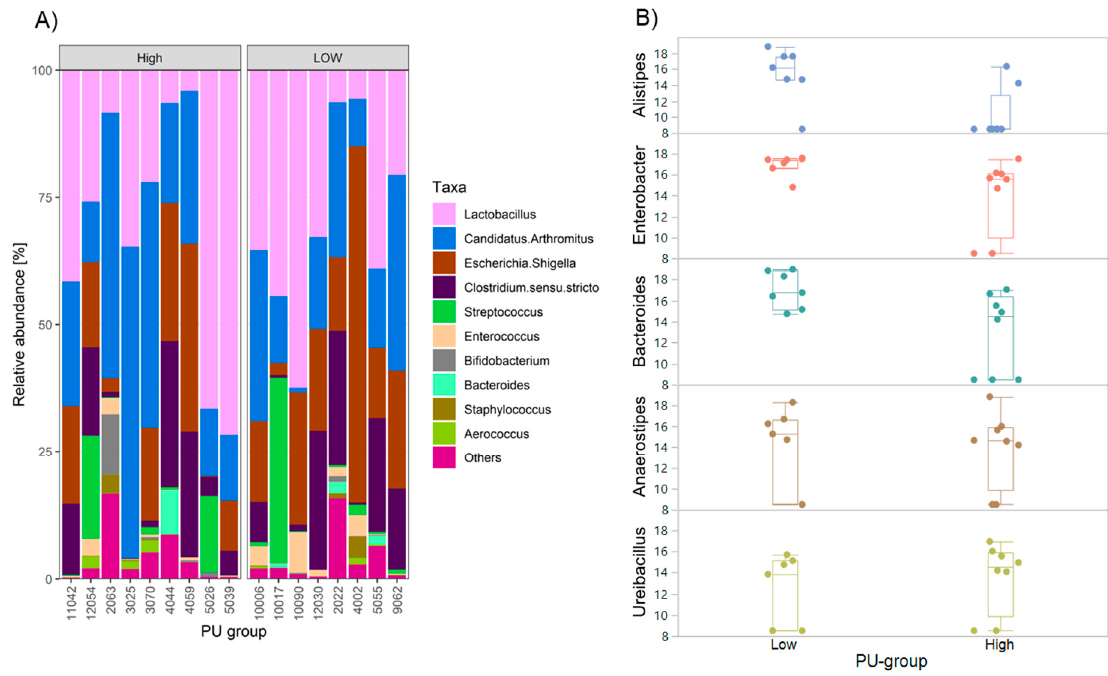
Figure 4. Characterization of microbial community composition and phosphorus utilization (PU; n = 17). ( A ) Microbiota variation at the genus level of ileum digesta samples of Japanese quail with high and low PU. Displayed is the relative abundances of the 10 most prevalent genera. ( B ). Significantly different ( q < 0.05) genera between high and low phosphorus utilization samples. X -axis indicates the normalized operational taxonomic units (OTU) using DESeq2. Each point represents a normalized OTU.